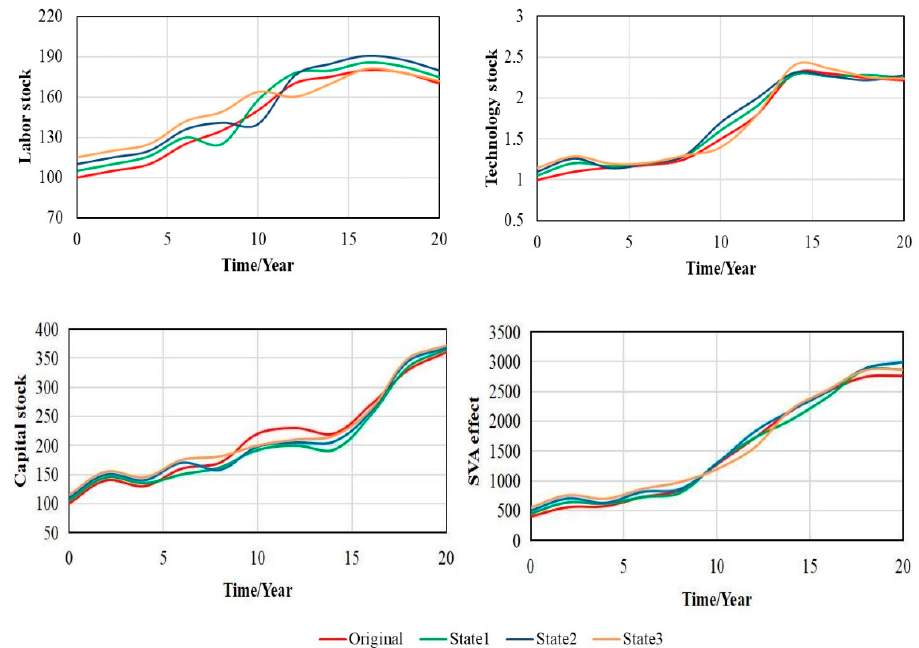
Figure 7. Sensitivity test. The Y axis has no units. Y axis indicates the degree, which is a unitless dimension. The red curve represents the initial state; Curves 1, 2, and 3 correspond to the trend lines of corresponding variables that increase by 5%, 10%, and 15%, respectively.